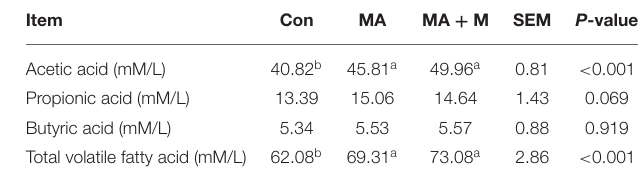
TABLE 3 | Effect of MA pretreatments on in vitro rumen fermentation parameters of rice straw.